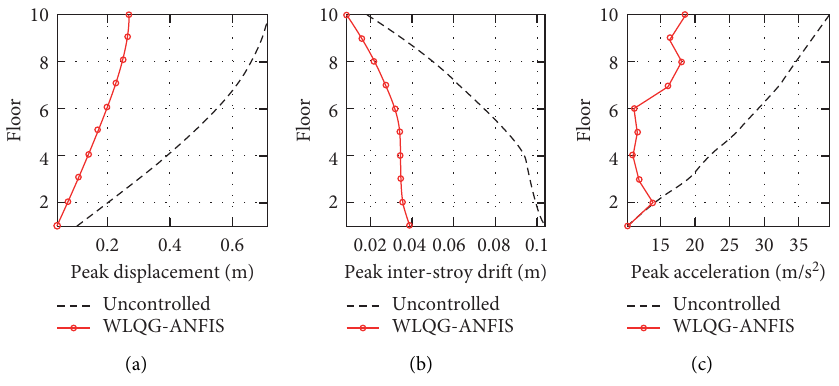
Figure 23: Peak responses due to scaled El-centro earthquake.